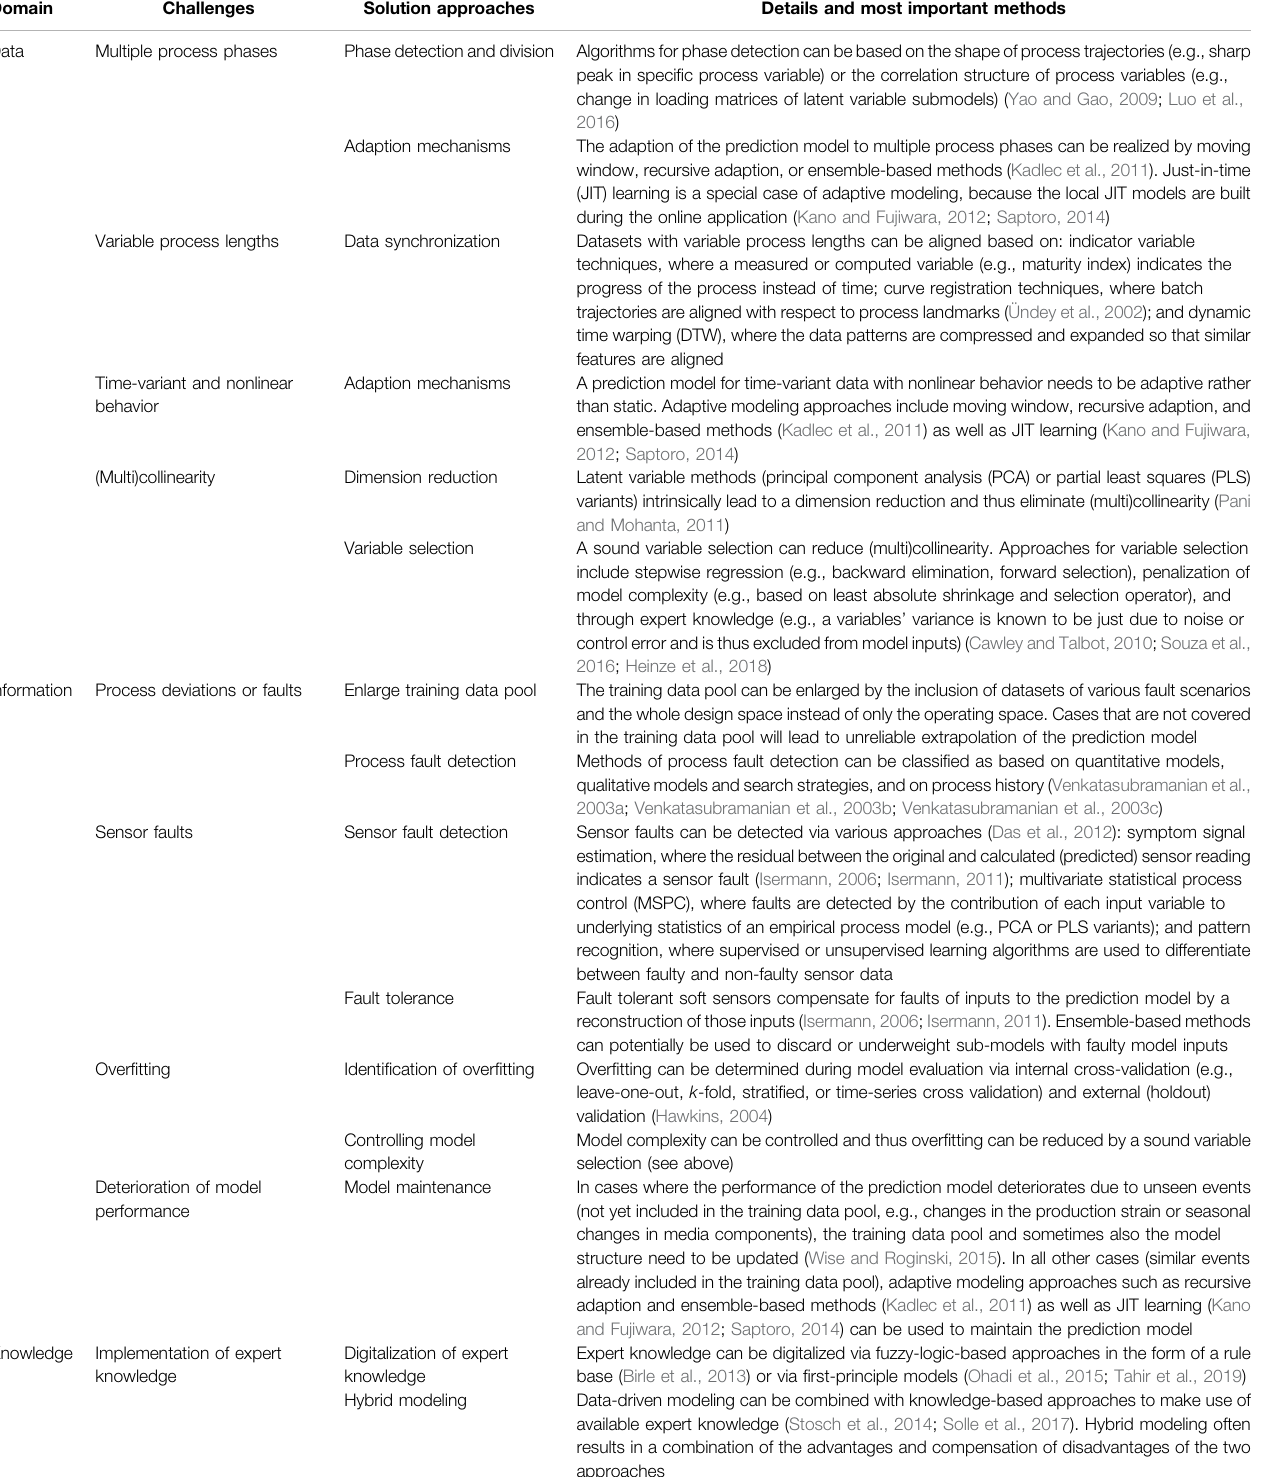
TABLE 1 | Overview of the most important challenges and corresponding solution approaches in the development of soft sensors. The challenges are herein broadly assigned to either the data, information, or knowledge domain.